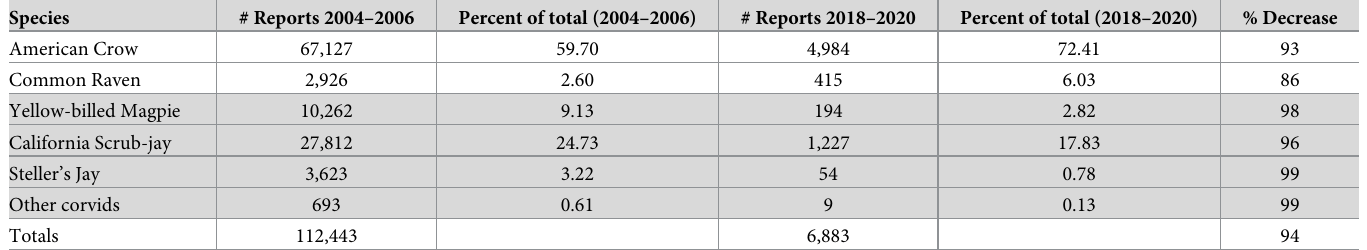
Table 3. Number of dead corvid reports and percent of total corvid reports, early versus later years. The last column is the overall percent decrease in reports; shaded species decreased proportionally while unshaded species increased